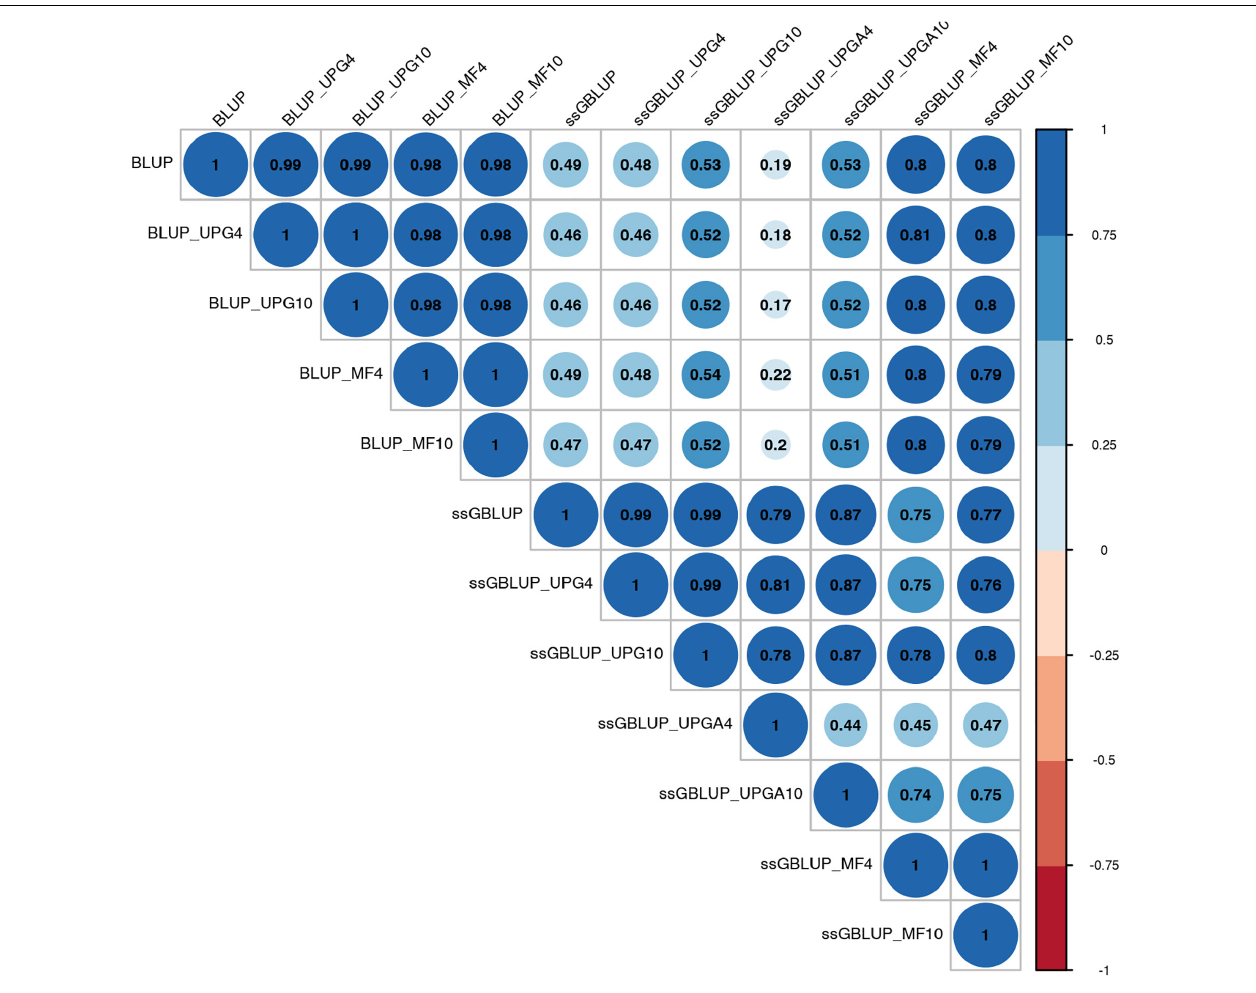
FIGURE 3 | Correlations between breeding values for weaning weight direct estimated using various models with and without genetic